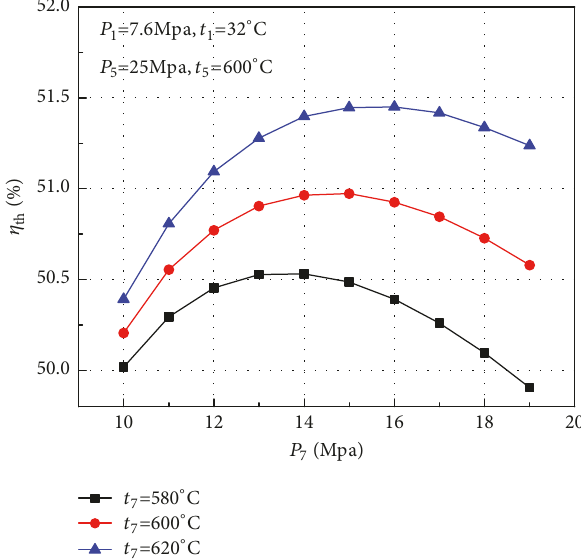
Figure 8: Effects of reheat stages on cycle efficiency at different HPT inlet pressure.